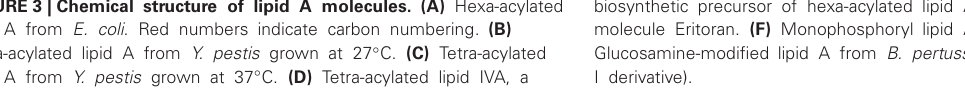
biosynthetic precursor of hexa-acylated lipid A. (E) The synthetic molecule Eritoran. (F) Monophosphoryl lipid A (MPLA). (G)